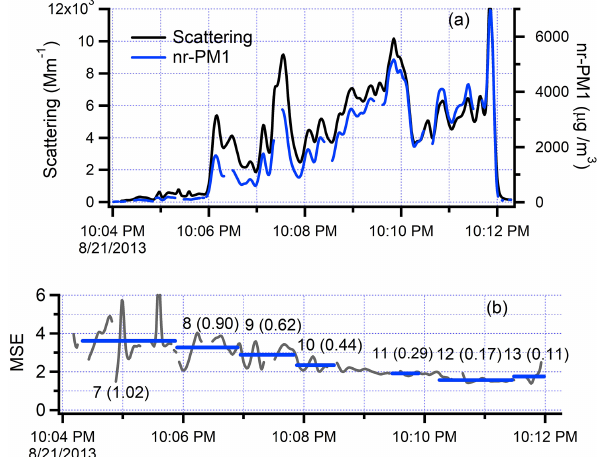
Figure 8. Time series from the along-plume segment of flight 821b. The smoke plume is entered 45km downwind of the fire at 20:04:30UTC. Time increases to the right as the G-1 approaches the fire front, which is crossed at approximately 20:12UTC. (a) Scat- tering and nr-PM1. Data from the nephelometer and SP-AMS have been smoothed with a 6 and 4s binomial filter, respectively. (b) Continuous MSE (black trace) constructed from data in Fig. 8a. Blue lines are transect-average values. Labels refer to transect num- bers shown in Fig. 7 with corresponding photochemical age in parentheses.